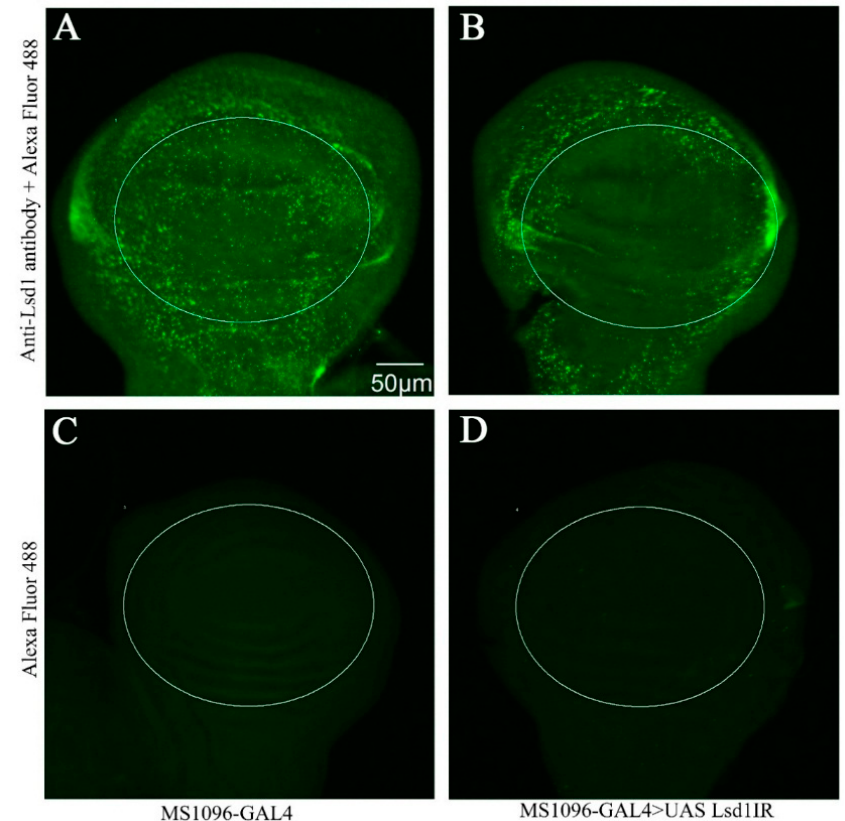
Figure 2. Immunostaining of wing imaginal discs with anti-Lsd1 antibody. ( A , B ) wing imaginal discs were reacted with rabbit anti-Lsd1 antibody followed by anti-rabbit IgG Alexa Fluor™ 488 antibody; MS1096-GAL4 flies ( A ) showed signal clearly and MS1096-GAL4 > UAS- Lsd1 IR flies ( B ) showed decreased Lsd1 signal in the wing pouch of wing imaginal discs ( C , D ) immunostaining of wing imaginal discs with only the anti-rabbit IgG Alexa Fluor TM 488 antibody showed no detectable signal; ( C ) MS1096-GAL4; ( D ) MS1096-GAL4 > UAS- Lsd1 IR. Flies were reared at 25 °C. The circles indicate